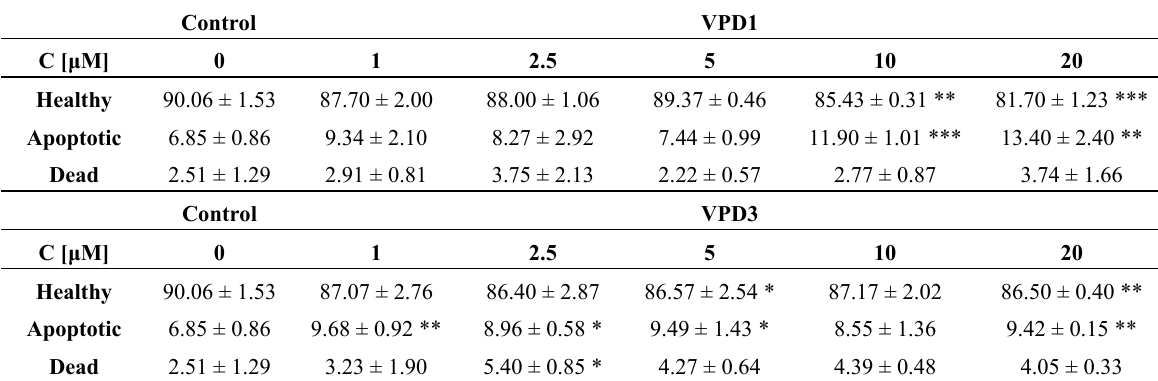
Table 1. Detection of healthy, apoptotic and dead hippocampal cells after 24 h exposure to VPD1 between concentrations 1–5 and 20 μ M for viable cells, 2.5 and 20 μ M, as well as 5